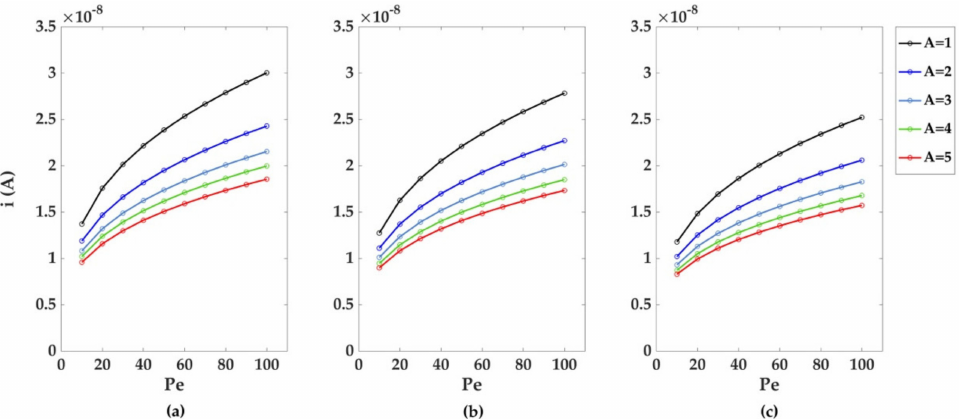
Figure 9. Dimensional currents for five different channel heights in the case of ( a ) bumped, ( b ) inlaid, and ( c ) recessed electrodes. The current values increased with increasing P é clet number value, and decreased as greater A values were considered.